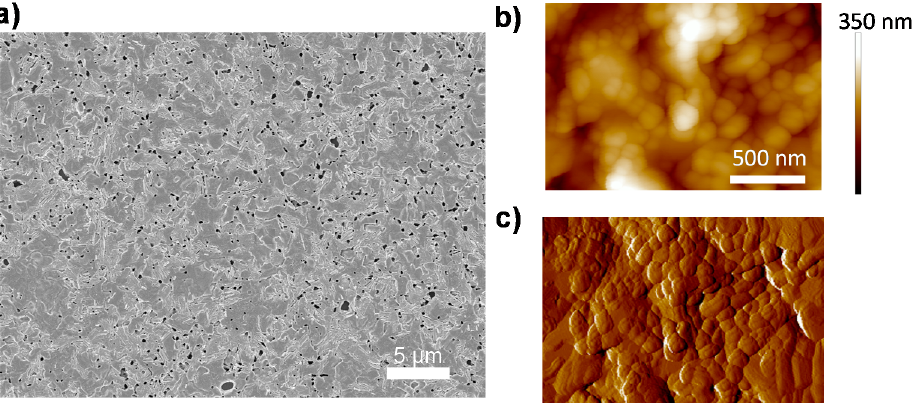
Figure 1. Morphology characteristics of a CH 3 NH 3 PbI 3 − x Cl x perovskite film. ( a ) Scanning electron microscopy (SEM) image; ( b ) atomic force microscopy (AFM) morphology image; and ( c ) AFM phase image. The color bar in ( b ) indicates height.